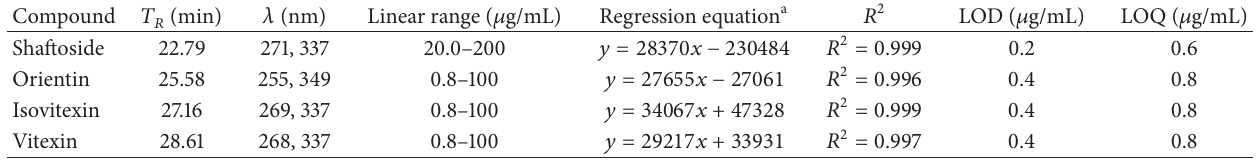
Table 1: Linear range, regression equations, LOD, and LOQ for quantitative analysis of HPLC ( 𝑛 = 3 ). Compound